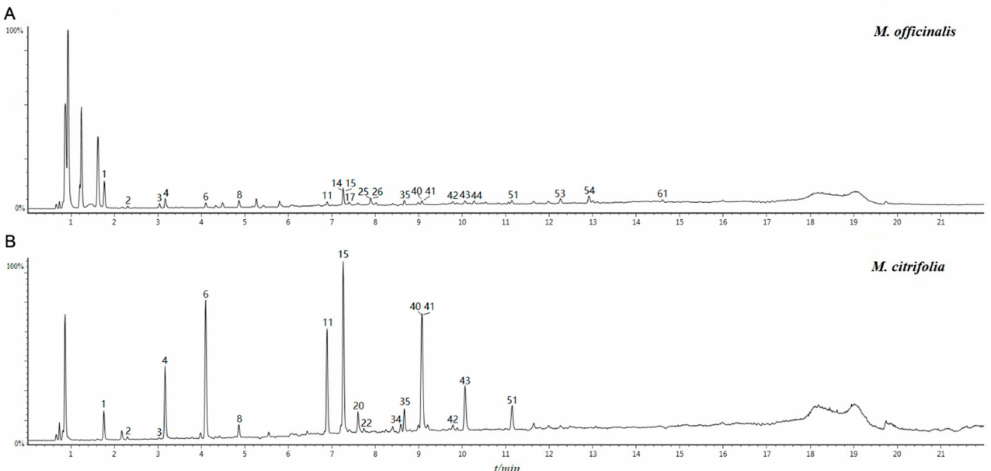
Figure 1. The total ion chromatogram (TIC) in the negative ion mode of samples: A for methanol extract of roots of M. o ffi cinalis roots, B for methanol extract M. citrifoli